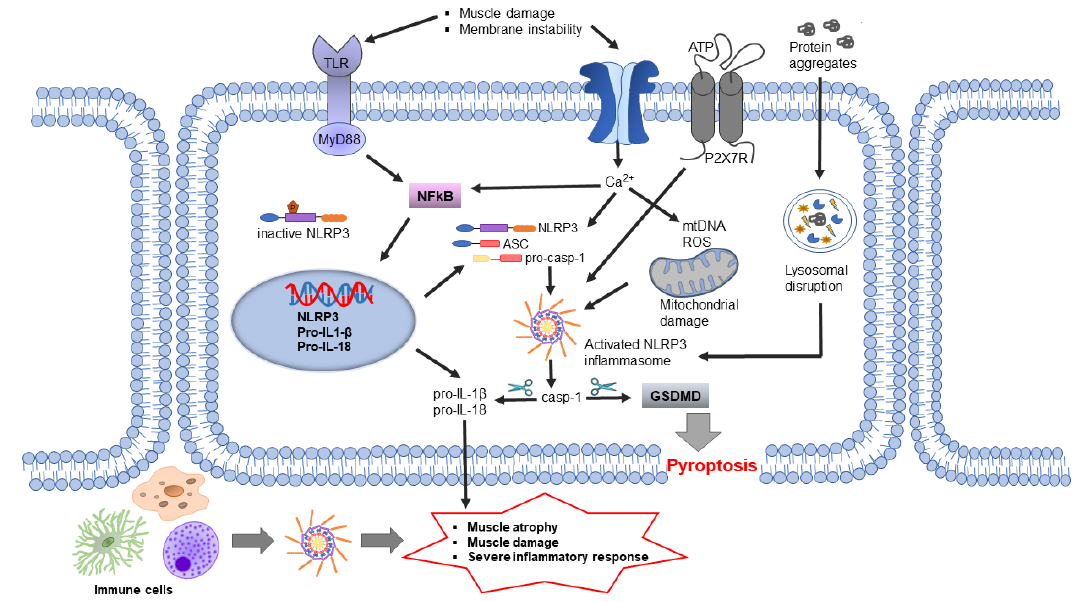
Figure 3. NLPR3 inflammasome involvement in muscular dystrophies. Disease-related effects via NLRP3 inflammasome activation in muscle tissues through membrane instability, extracellular ATP, Ca 2+ ion influx or through signals from infiltrating immune cells.